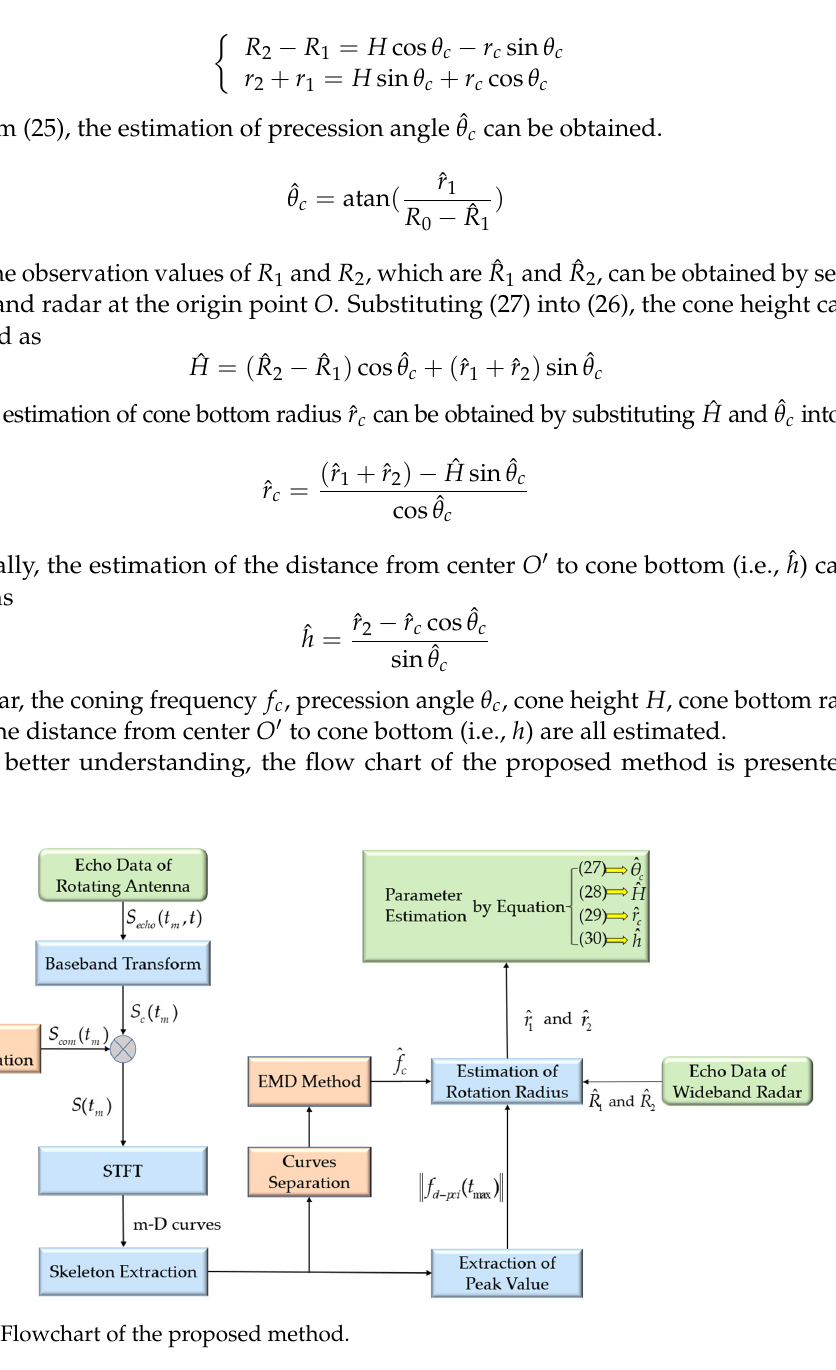
Table 1. Simulation parameters of radar and target.